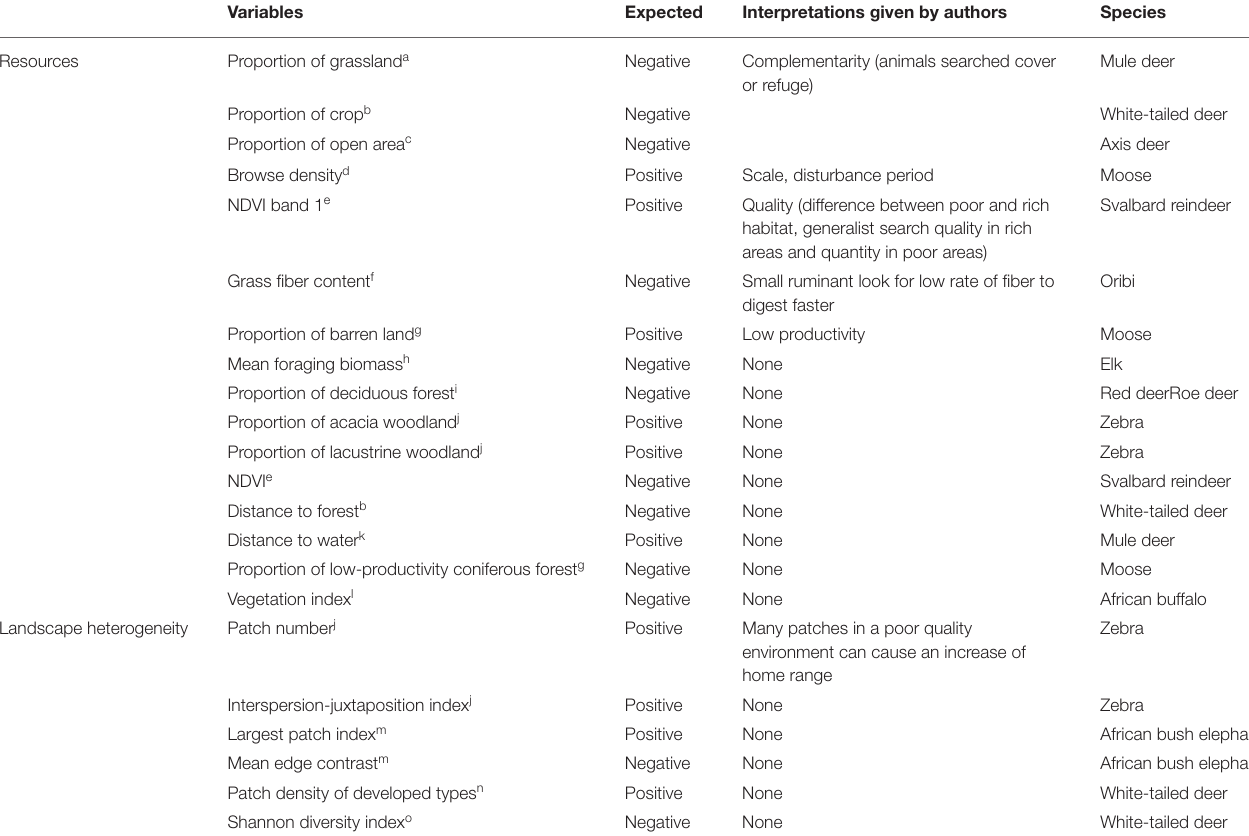
TABLE 3 | Biological interpretations provided by authors to explain results that were retained as opposite to initial biological hypothesis, per category of variable (resource availability and landscape